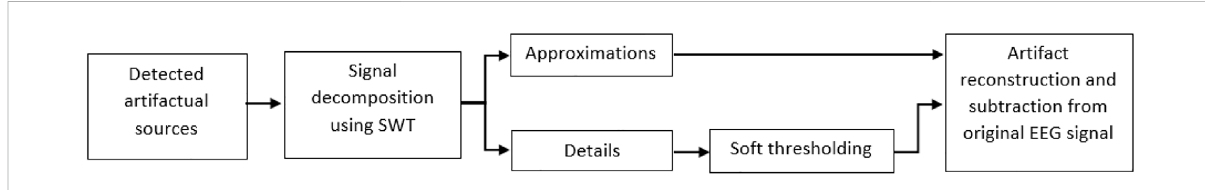
FIGURE 2 The block diagram for the proposed artifact elimination method based on one-level SWT with “ haar ” wavelet basis function as its wide usage in EEG preprocessing